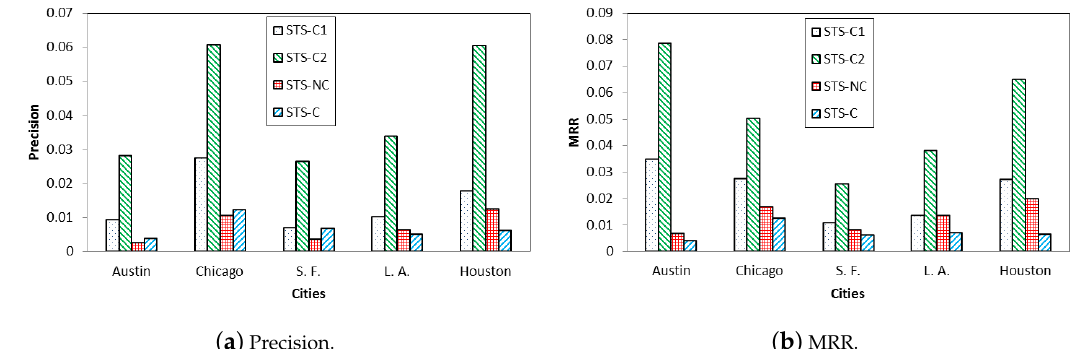
Figure 6. Impact of semantic